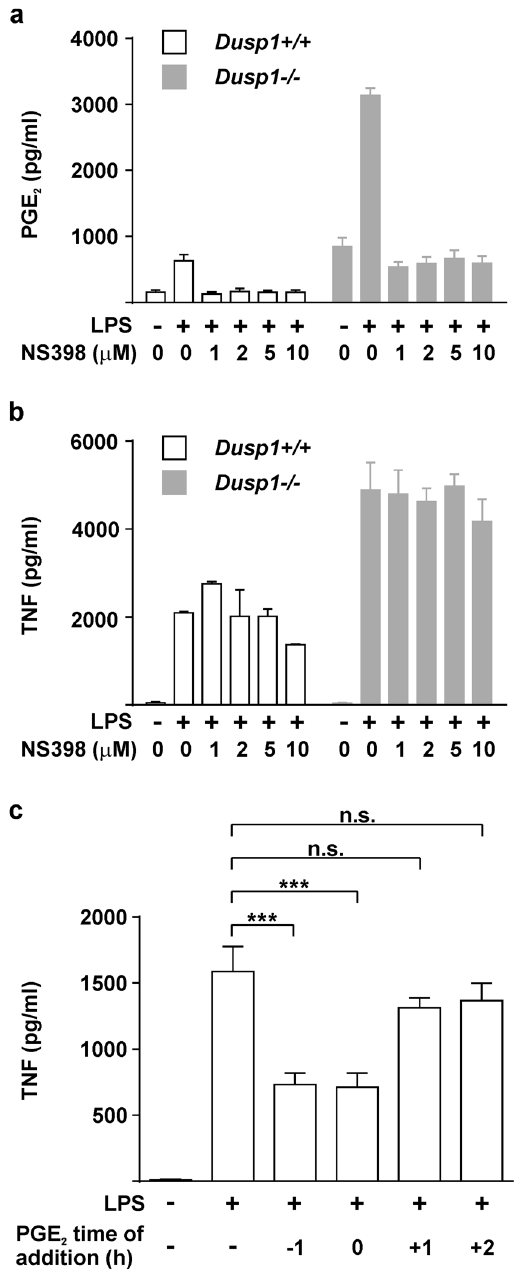
Figure 6. Anti-inflammatory effects of PGE 2 are strongly time-limited. Dusp1 + / + and Dusp1 − / − BMMs were stimulated with 10 ng/ml LPS in the presence of the indicated concentrations of NS398. PGE 2 ( a ) and TNF ( b ) were measured by ELISA. Graphs represent mean ± SEM from three independent BMM cultures of each genotype. ( c) Wild type BMMs were stimulated with 10 ng/ml and harvested four hours later for measurement of TNF by ELISA. PGE 2 (1 nM) was added at different time points with respect to the addition of LPS at t = 0. The graph shows mean ± SEM from three independent cultures of BMMs. n.s., not statistically significant; *** p < 0.005;